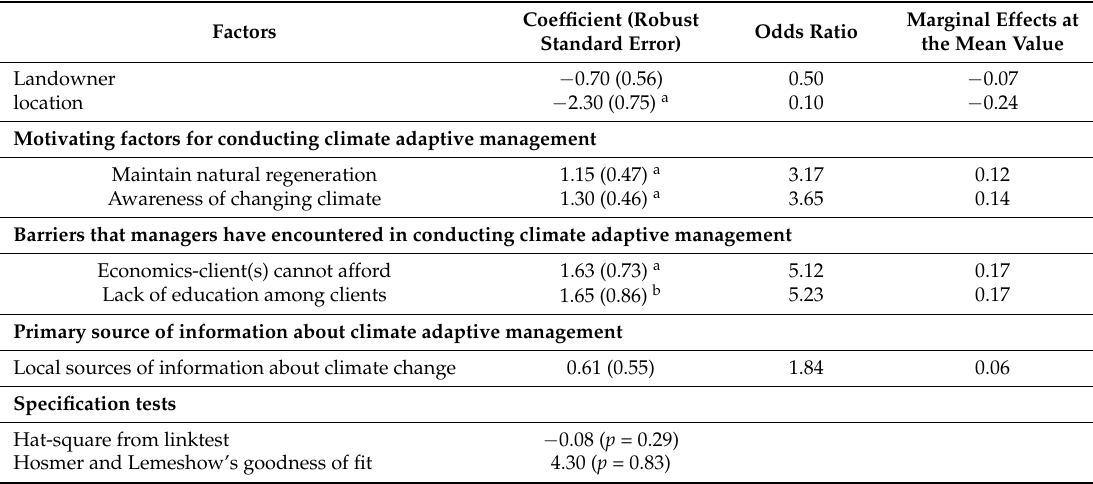
Table 2. Logistic regression results highlighting the factors influencing resource managers’ decision on changing forest management activities to adapt to climate change ( N = 153) Dependent variable = 1 if managers alter their forest management actions and activities, 0 otherwise. The estimated marginal effect indicates that predicted probability of altering forest management activities by respondents who selected a motivating factor or barrier as compared to other